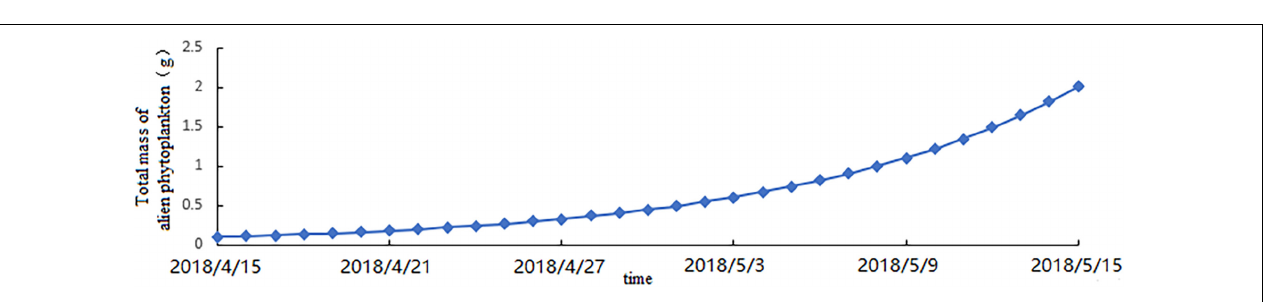
FIGURE 8 | Mass of alien phytoplankton in Bohai Bay ( µ (cid:48) = 0 day − 1 ).